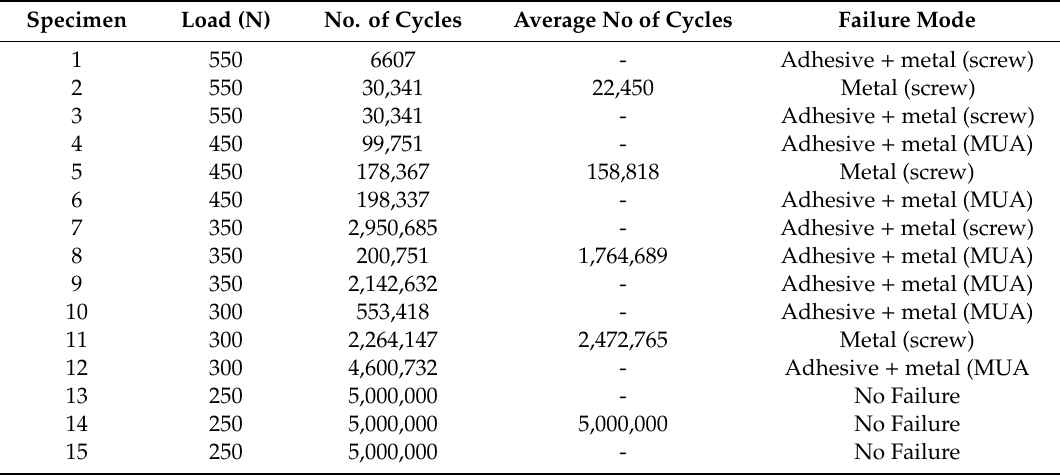
Table 3. Fatigue test results for group B (screwed-cemented